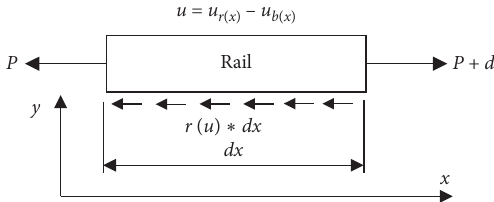
Figure 1: Longitudinal balance of infinitesimal rail.